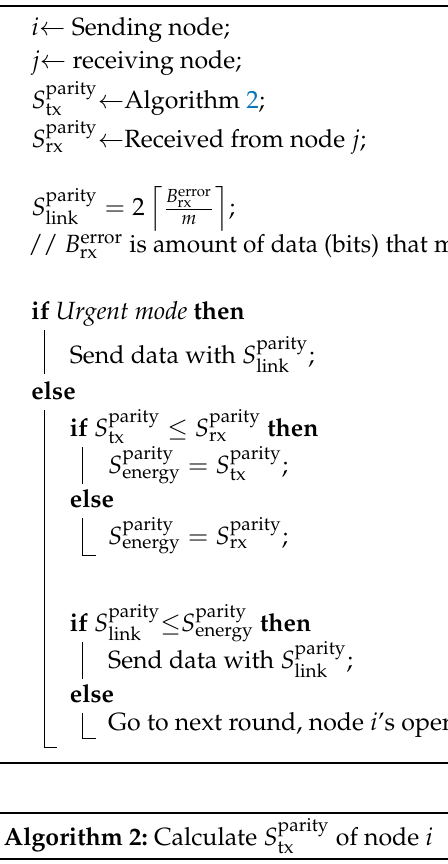
Algorithm 1: Operation of sending node i in 1